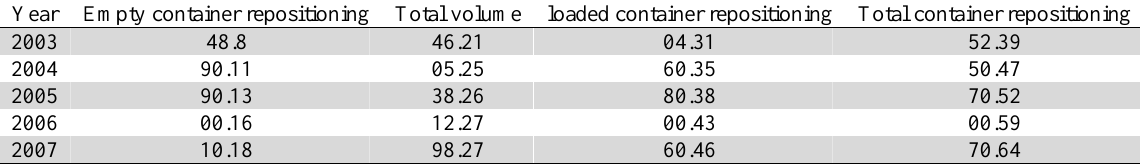
Empty container repositioning verses full container repositioning base on TEU million under the strategy